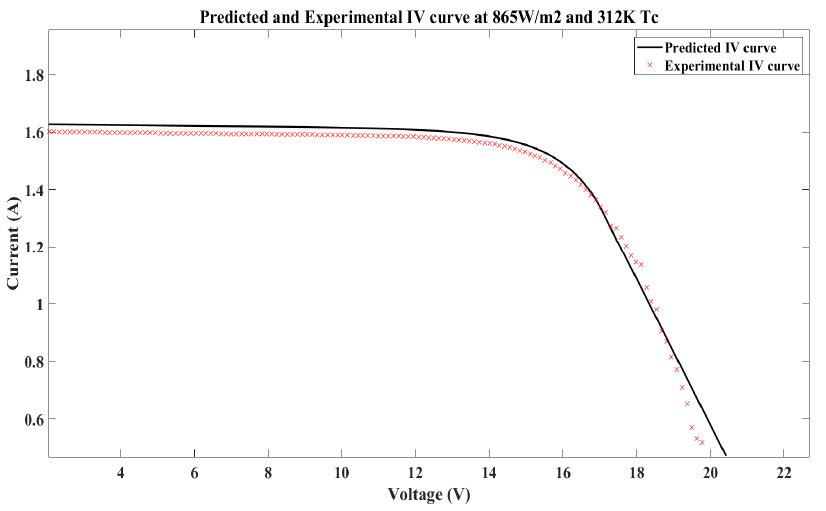
Figure 11. Predicted and experimental IV curves for monocrystalline module at 640 W/m 2 and 324K Tc.